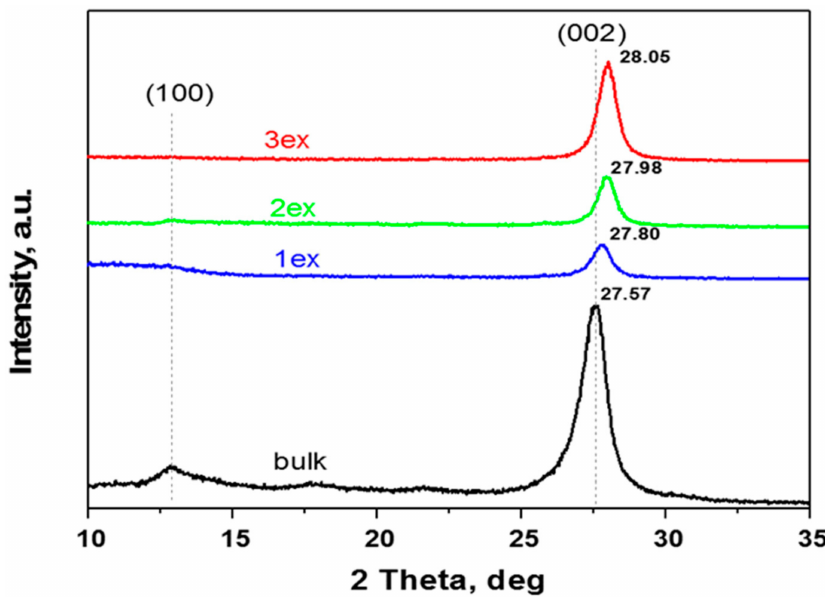
Figure 1. Patterns of the synthesized (bulk) and exfoliated (1ex, 2ex and 3ex) g-C 3 N